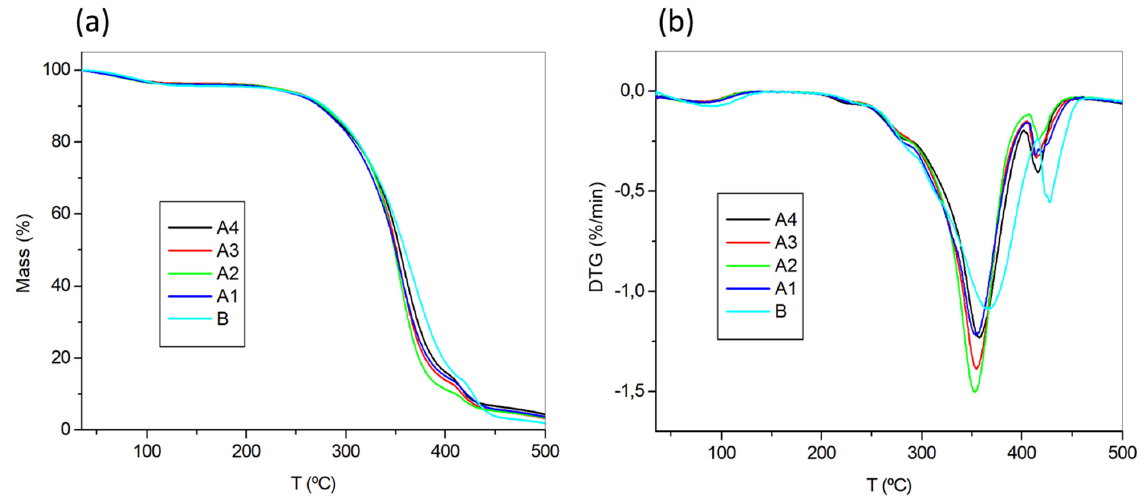
Figure 3. ( a ) Thermograms for films A1 – A4, B and ( b ) the first derivative of such thermograms. Analysis of the materials by ATR-FTIR yielded a series of spectra with almost iden-